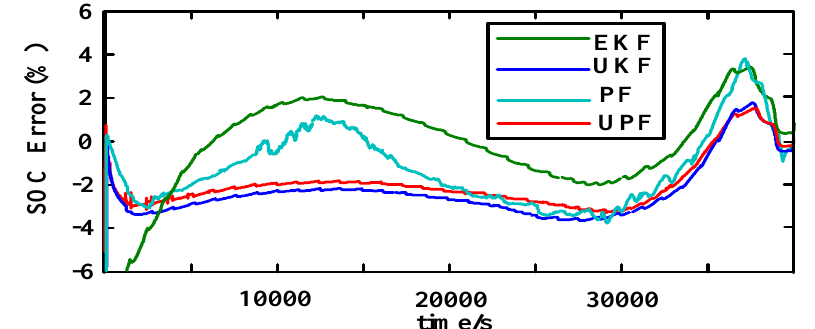
Figure 15. Estimation error curves of di ff erent algorithms at − 10 ◦ C. Table 8. Maximum Estimation Error of Di ff erent Algorithms at − 10 ◦ C.